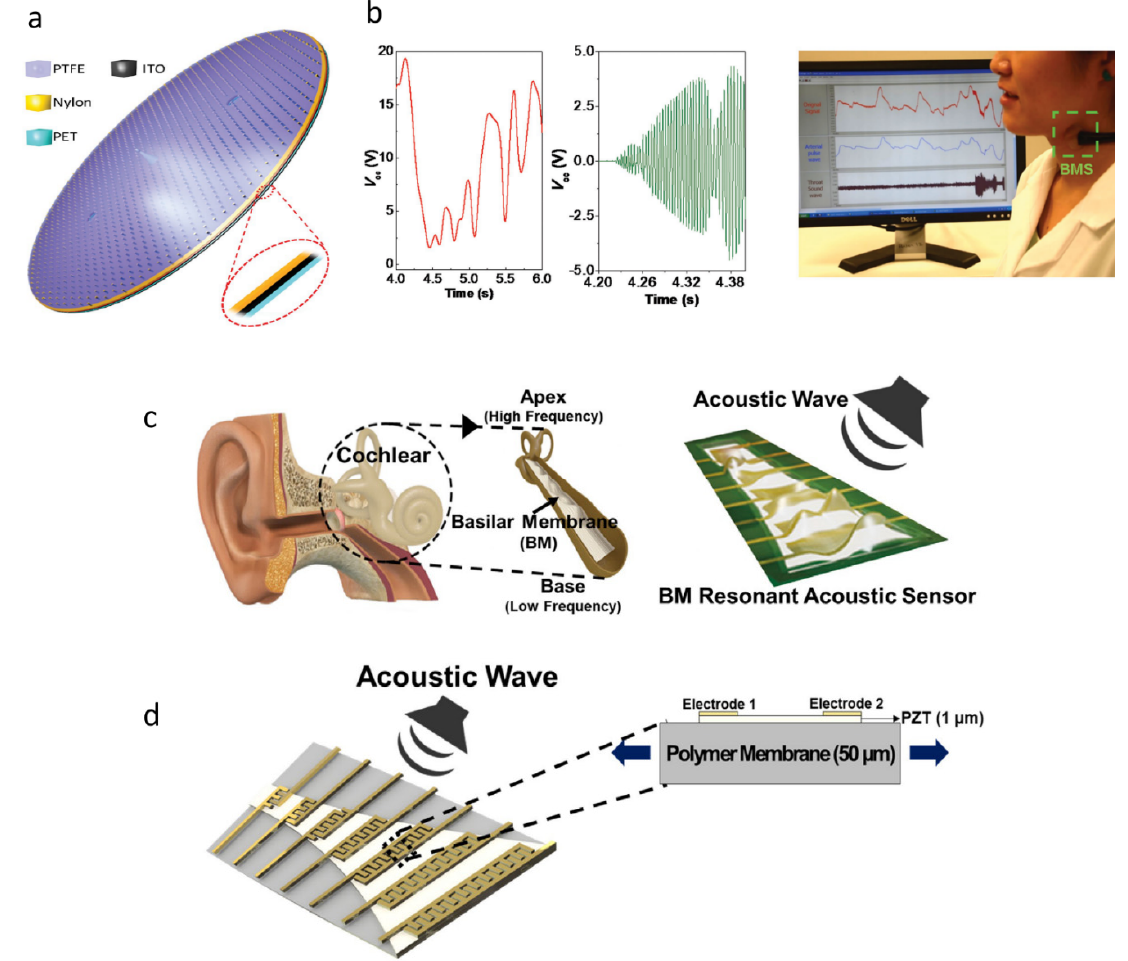
Figure 6. ( a ) Schematic diagram of the acoustic sensor. ( b ) Images showing the low-frequency component and high-frequency component of the output signals when the TENG is worn on the neck as a self-powered throat microphone [39]. Copyright 2015, Wiley. ( c ) Graphic image of the basilar membrane (BM) in the human cochlear which is naturally designed with an asymmetric trapezoidal shape and the sketch of the multi-channel piezoelectric acoustic sensor inspired by the resonant structure of the BM. ( d ) Schematic diagram of the sensor in response to the sound wave and the enlarged cross-sectional image of the dashed acoustic sensor part [40]. Copyright 2018, Elsevier.